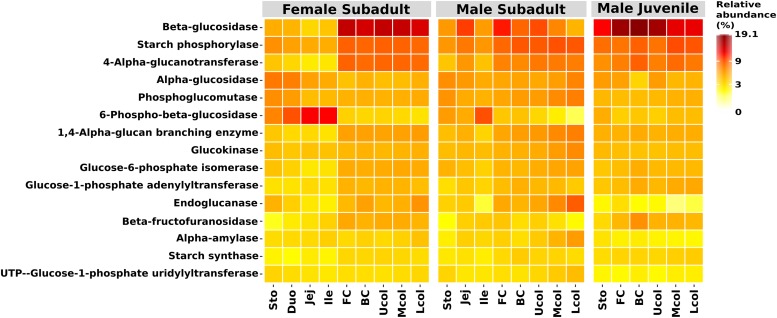
Functional prediction of the top 15 functions in the KEGG categories starch and sucrose metabolism. Shown are the relative abundances. Functional prediction was performed with Tax4Fun (Aßhauer et al., 2015).